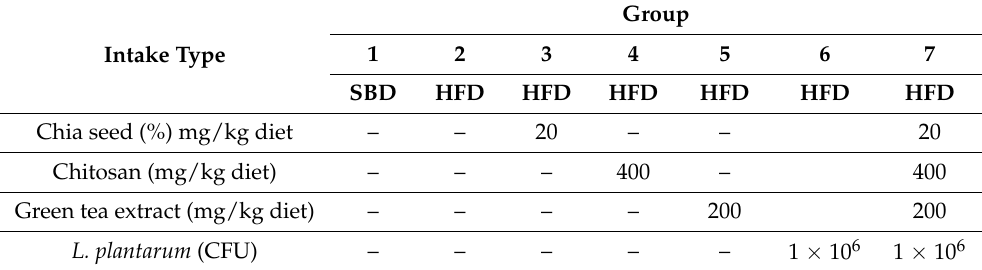
Table 5. Group distribution and experimental